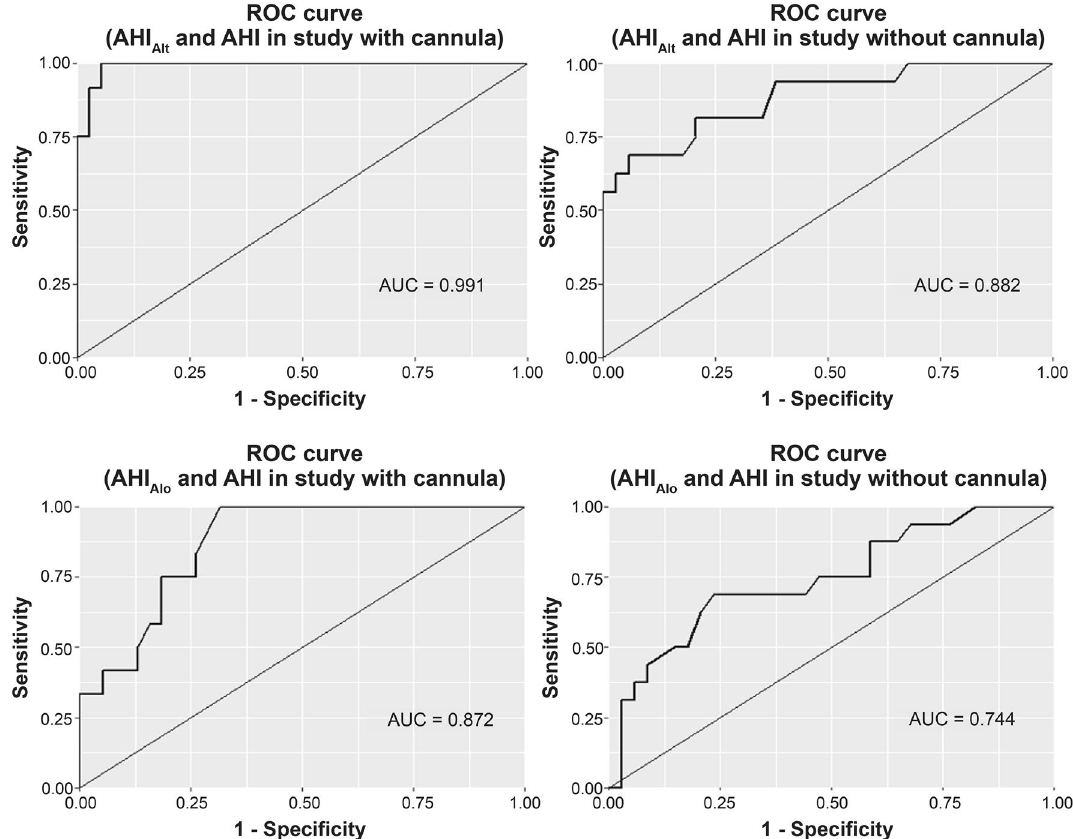
Figure 4. ROC curves to determine the sensitivity and specificity of AHI comparing standard sensor and IR/ IR2 sensor data. AHI apnea–hypopnea index, Alo infrared alone, Alt infrared with standard sensor, AUC area under the curve, ROC receiver operating characteristic.